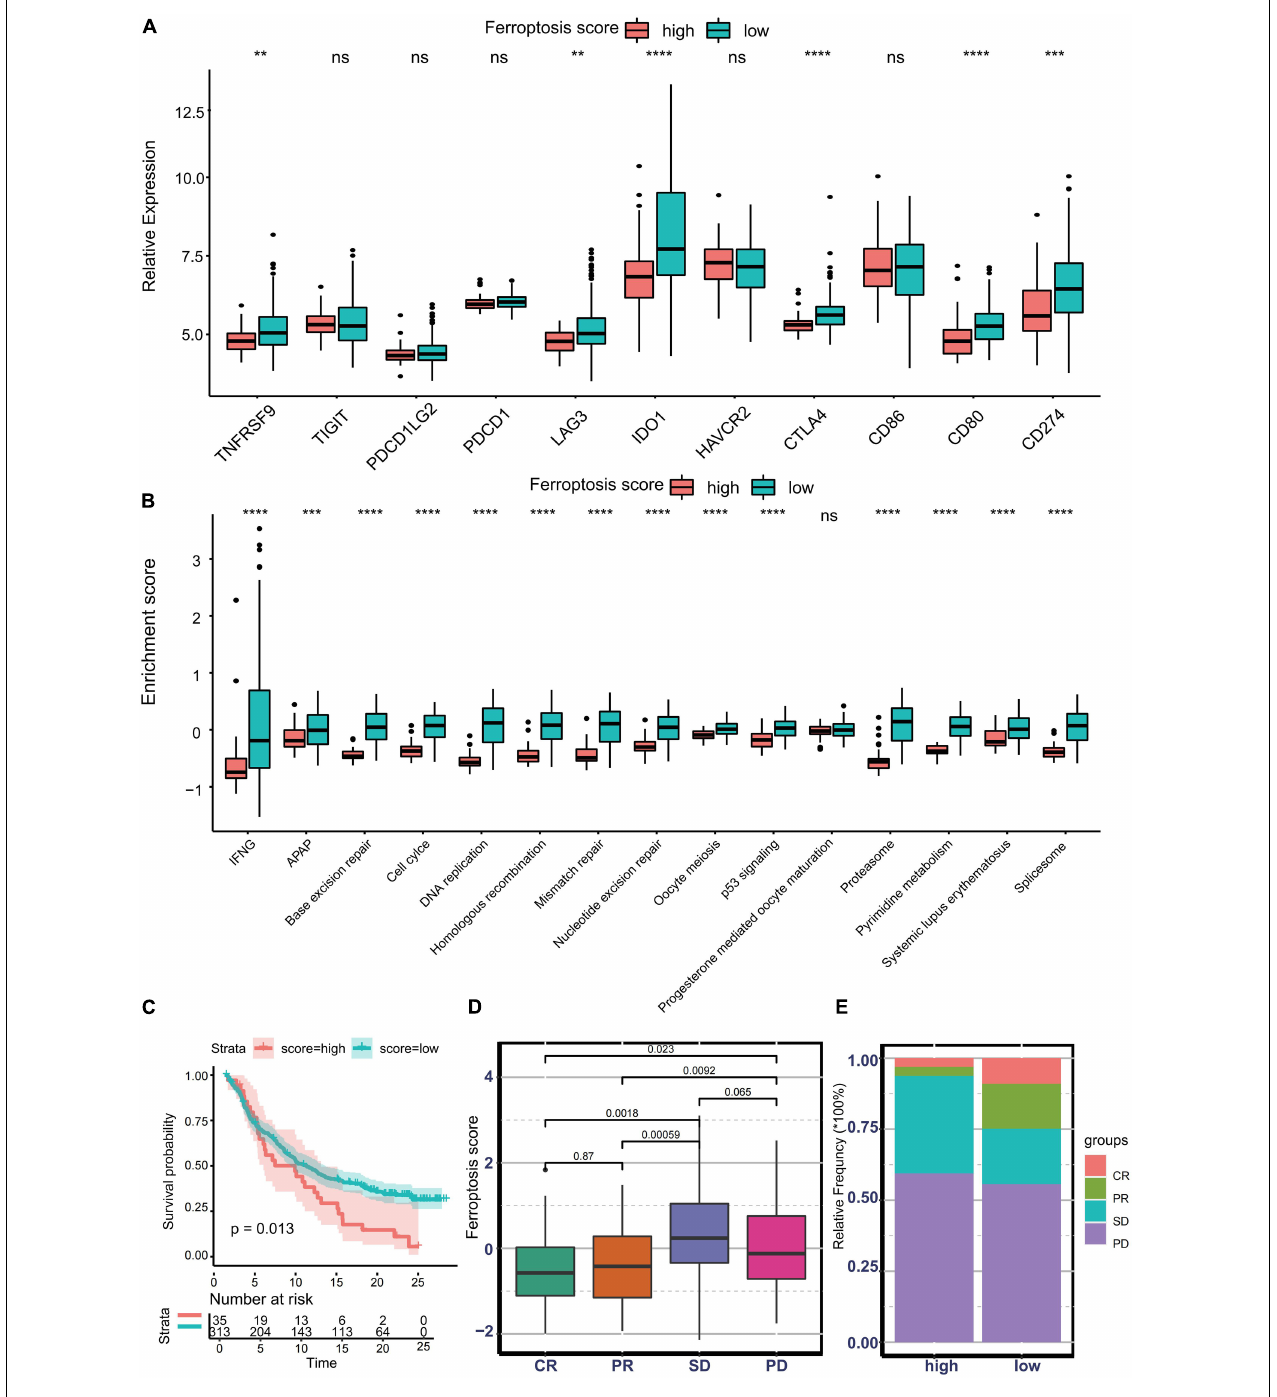
FIGURE 7 | Predictive value of the ferroptosis score for response to immunotherapy. (A) Different expression profiles of immune checkpoint-related genes in patients with low or high ferroptosis scores in the Asian Cancer Research Group (ACRG) cohort (** p < 0.01; *** p < 0.001; **** p < 0.0001). ns , no significance. (B) Different activation status of immunotherapy-positive gene signatures in patients with low or high ferroptosis scores in the ACRG cohort (*** p < 0.001; **** p < 0.0001). ns , no significance. (C) Kaplan–Meier curves showing overall survival in patients with low or high ferroptosis scores in the immunotherapy cohort. (D) Distribution of the ferroptosis scores in distinct anti-PD-L1 clinical response groups. (E) Relative frequency of each anti-PD-L1 clinical response group in groups with low or high ferroptosis scores.